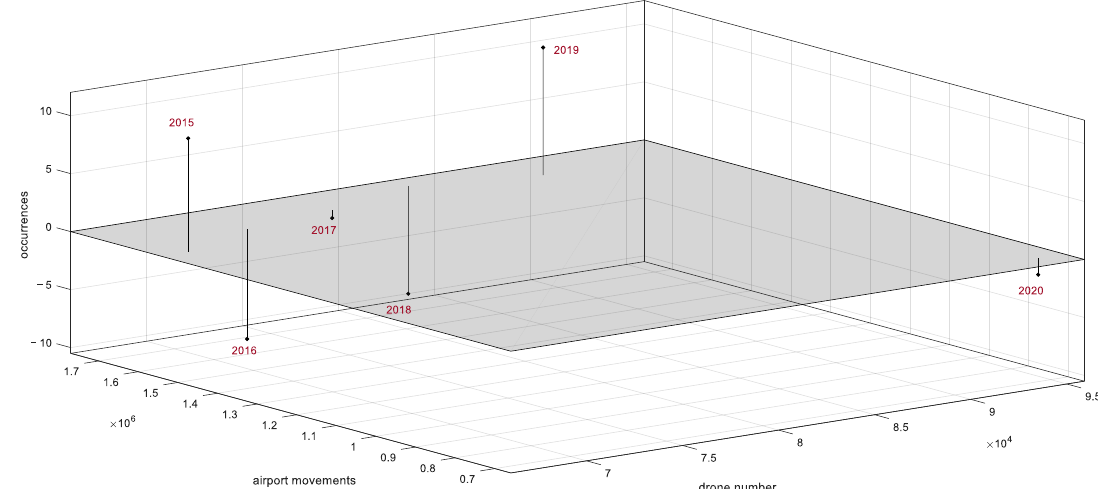
Figure 10. Residuals of AVI model for the Italian the yearly number of drone intrusions in the period 2015 – 2020.